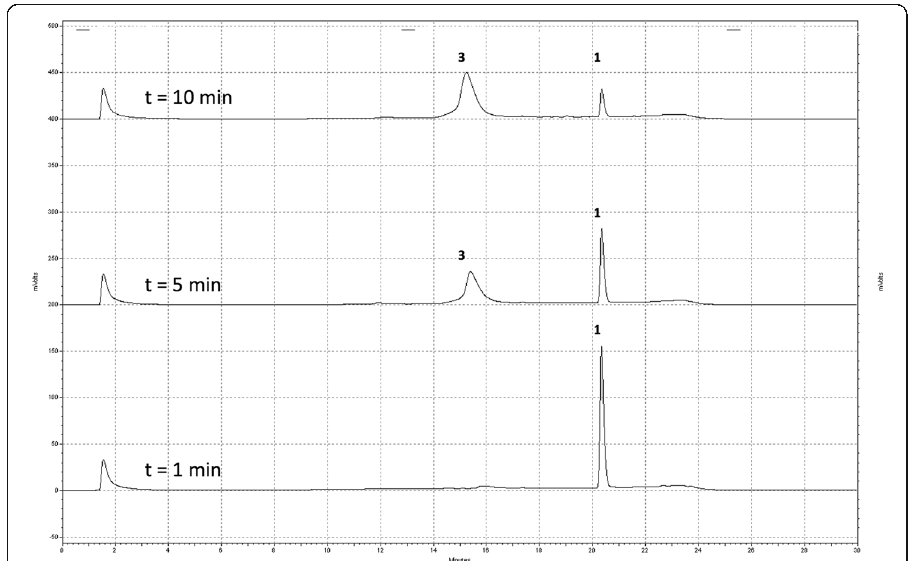
Fig. 5 HPLC traces at 1 min, 5 min and 10 min of AV1451 precursor in DMSO at 130